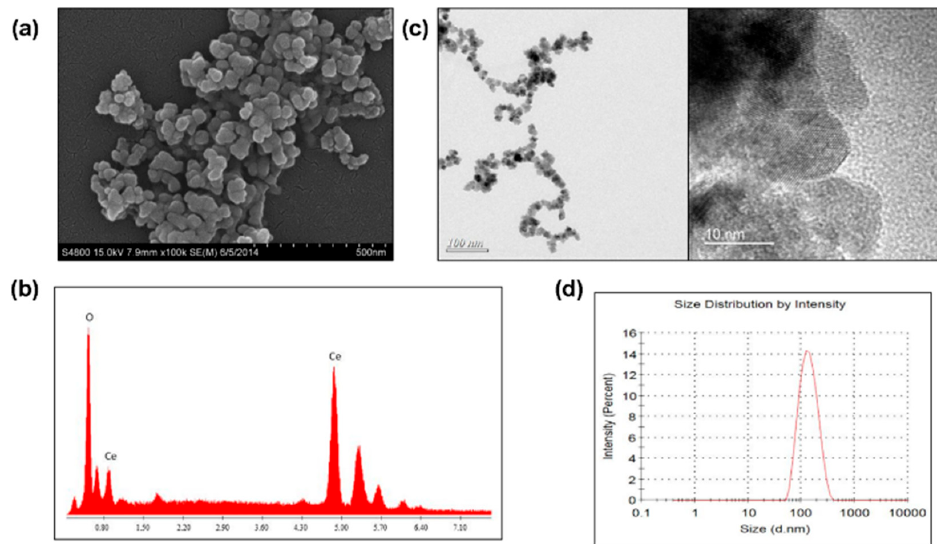
Figure 1. Morphology and composition of CeO 2 nanoparticles. The morphology and composition of CeO 2 nanoparticles. ( a ) The surface topography of cerium oxide nanoparticles; ( b ) The EDXA pattern of cerium oxide nanoparticles; ( c ) The TEM image of cerium oxide nanoparticles; ( d ) Particle size distribution.